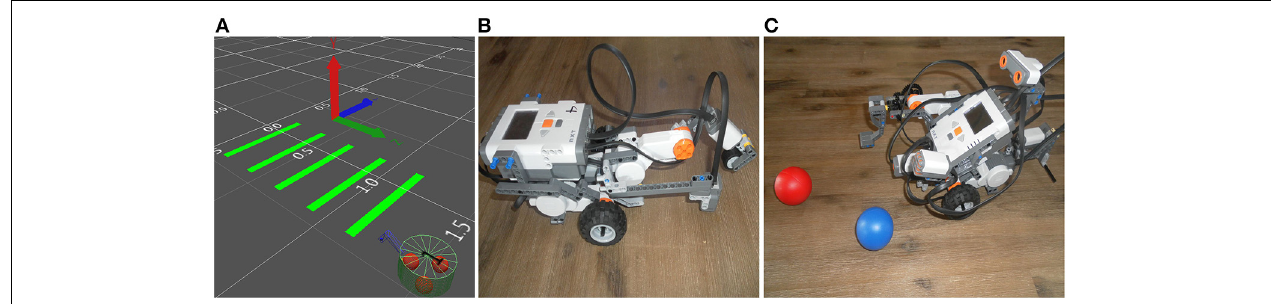
FIGURE 2 | (A) Representative third person view of NeuroSim, the 3D-world simulator in the SIMCOG suite, showing a picture of the virtual robot when attempting to cross several green bars on the floor. (B,C) Similar structures with physical robots (Lego Mindstorms NXT 2.0).